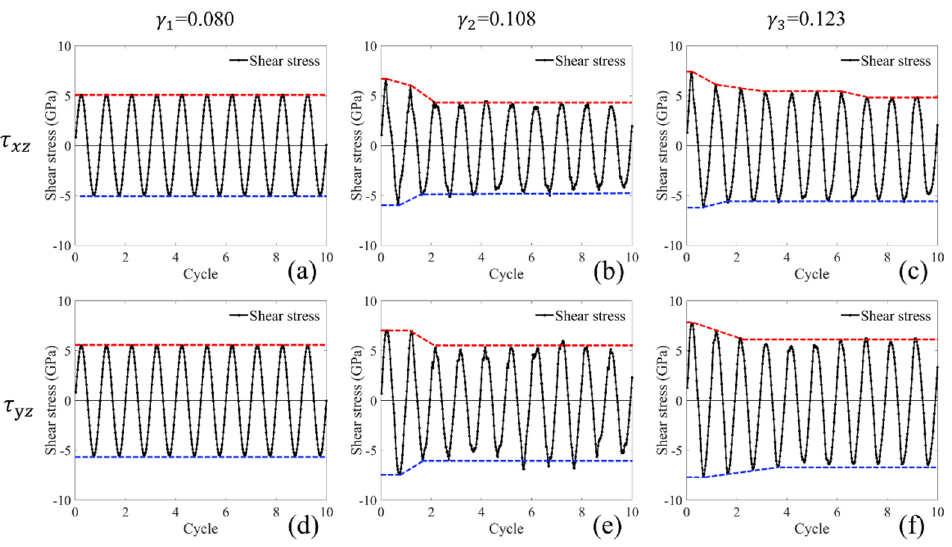
Figure 6. Shear stress-cycle responses under different loading conditions. Applied shear strain of ( a , d ) γ 1 , ( b , e ) γ 2 and ( c , f ) γ 3 . Loading directions are along ( a – c ) the x -axis and ( d – f ) the y -axis, respectively. Red and blue dash lines represent the trends of maximum and minimum stress amplitudes, respectively.